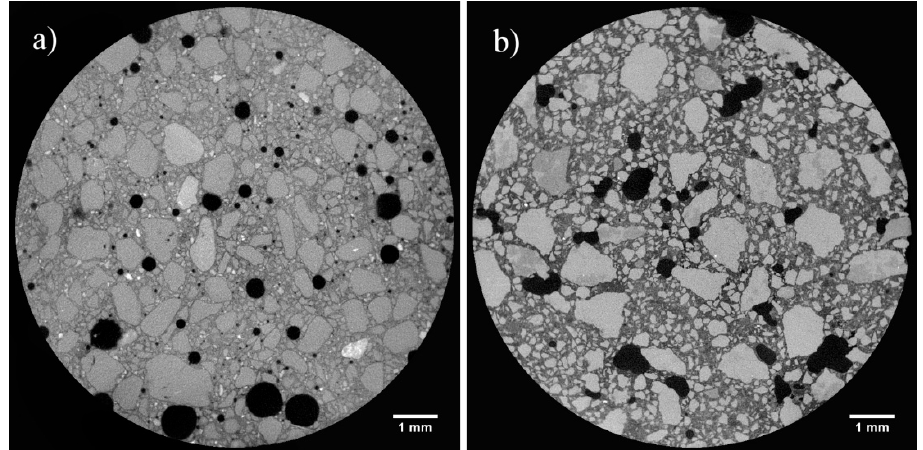
Figure 7. Slices of X-ray tomography of samples ( a ) NQ and ( b ) NM.